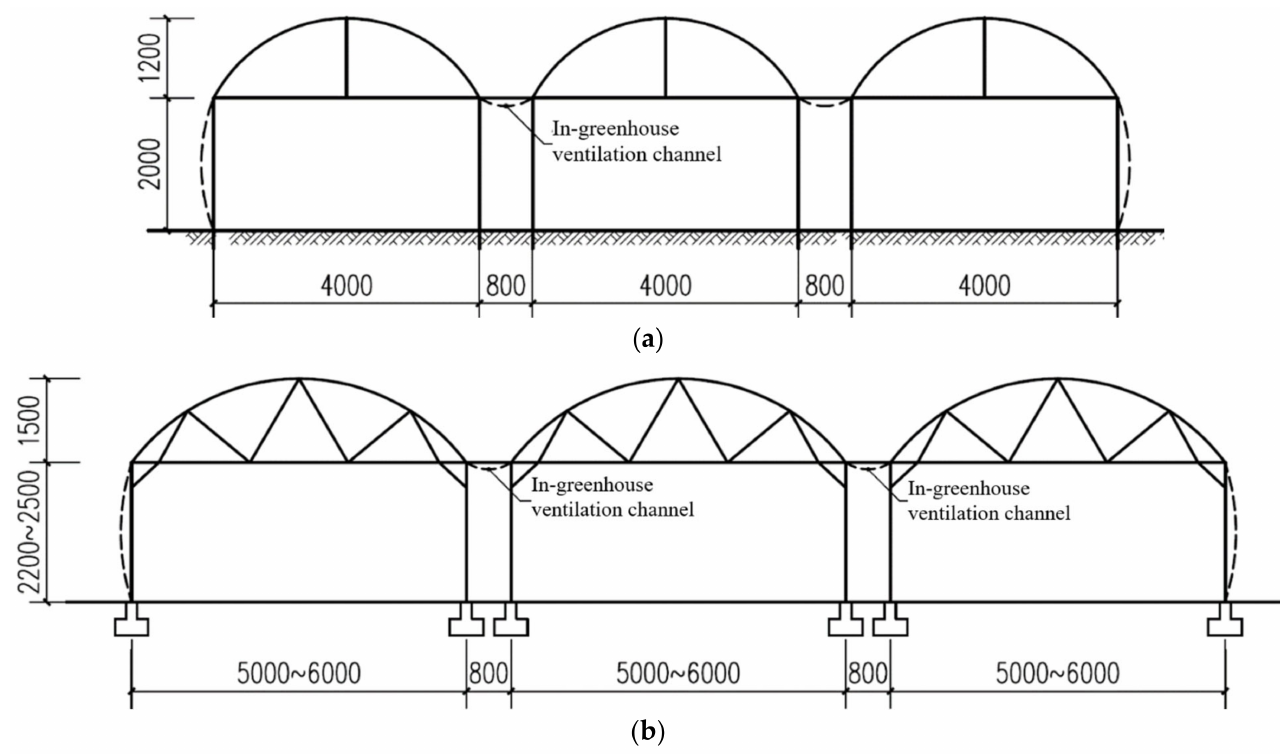
Figure 2. Multi-span round arch plastic greenhouse with an in-greenhouse ventilation channel (unit: mm). ( a ) Structure of the cantaloupe greenhouse; ( b ) Structure of the Hainan year-round vegetable production